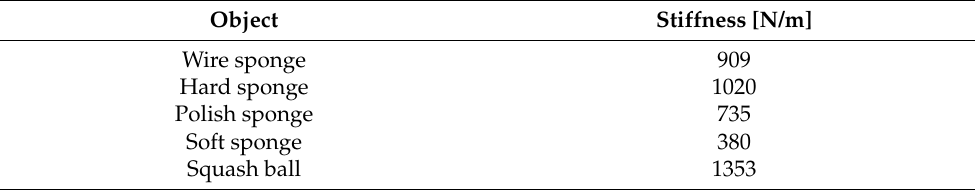
Table 1. Stiffness coefficients computed for 5 different real objects.